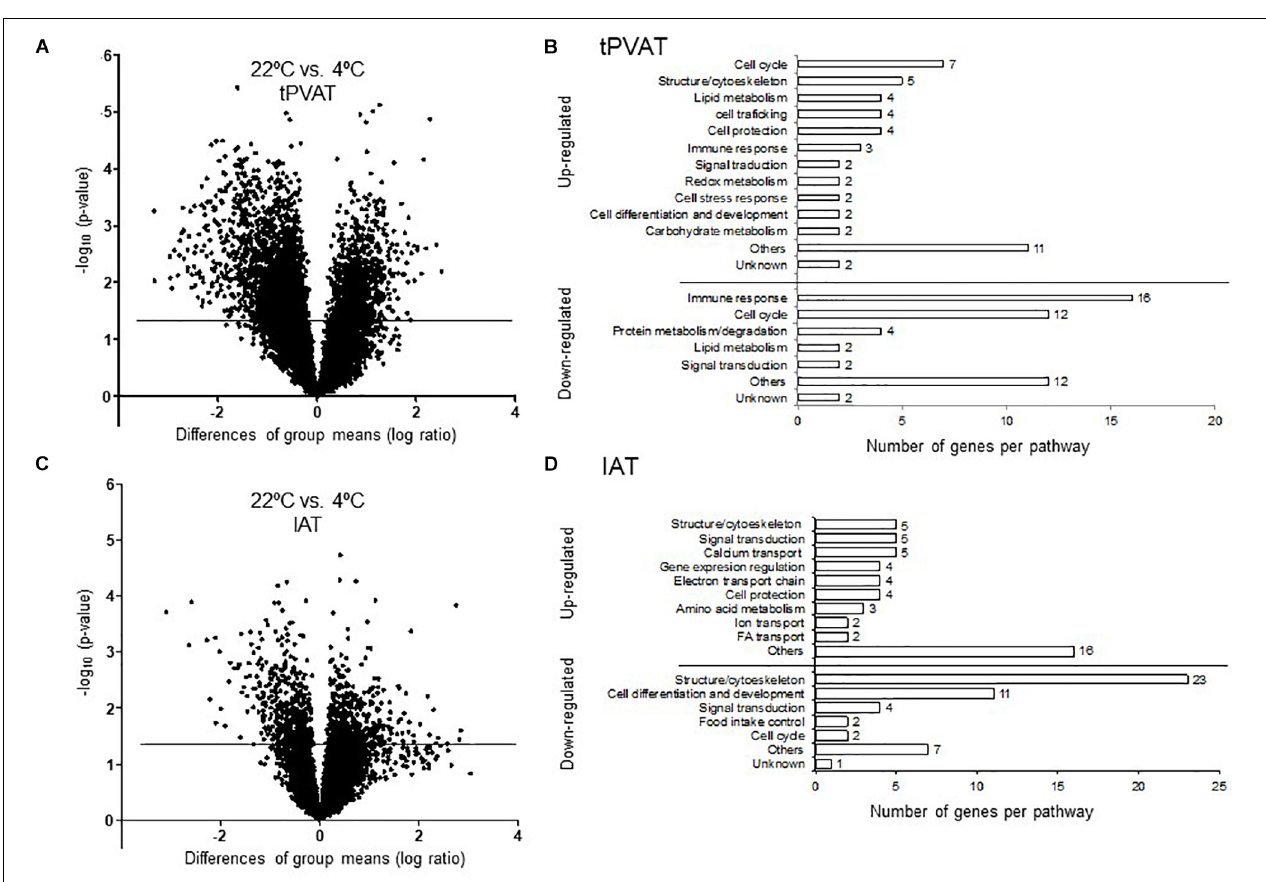
FIGURE 4 | Volcano Plot for all expressed probes by microarray analysis in tPVAT (A) and IAT (C) . Minus log10 p -value of all genes are plotted against the differences of group means (log ratio) of each gene, cold vs. control. The line indicates the threshold p -value < 0.05. Detailed manual classification of the 50 top up- and down-regulated genes based on their fold change (Student’s t -test, p -value < 0.05) in tPVAT (B) and in IAT (D) . The results represent data from the control ( n = 7) and cold ( n = 6–7)